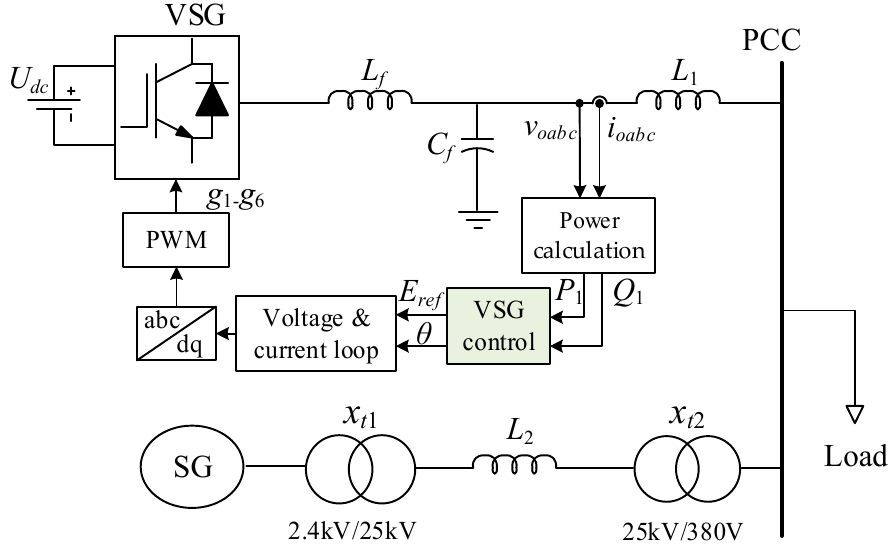
Figure 1. Main circuit and control diagram of VSG-SG coupling system.